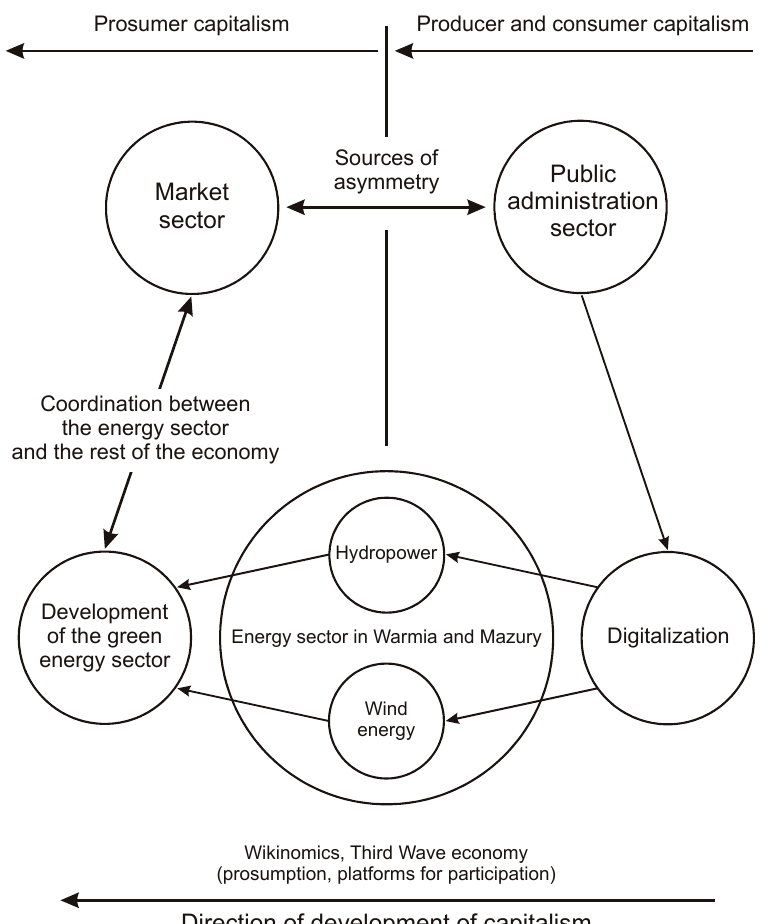
Figure 1. Transformation of the renewable energy sector in Warmia and Mazury in the process of transition from producer and consumer capitalism to the prosumer capitalism.